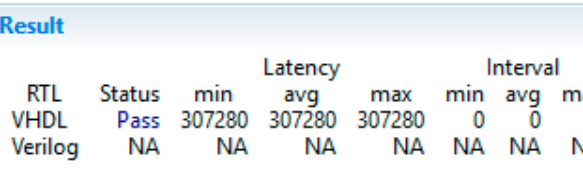
Figure 7. RTL verification report.